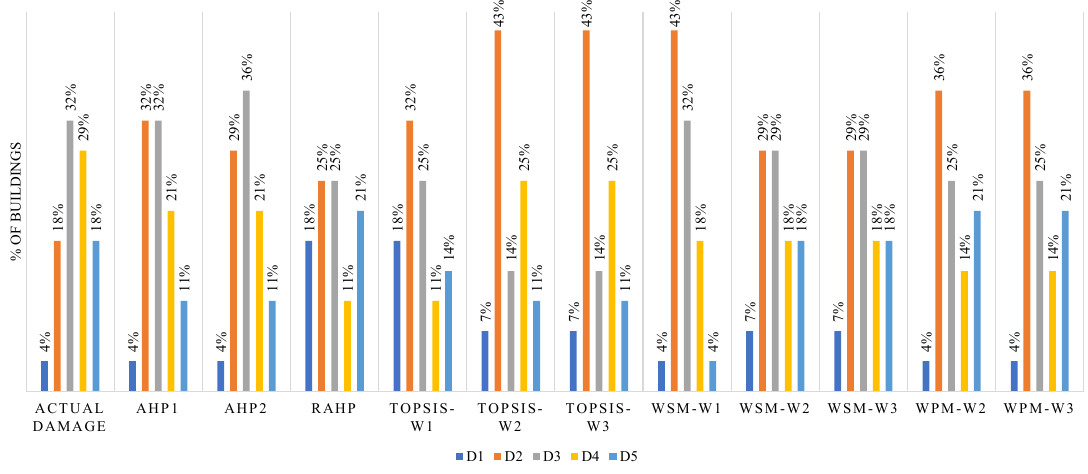
Figure 11. Percentage of each damage group assessed by different MCDM methods and actual damage.